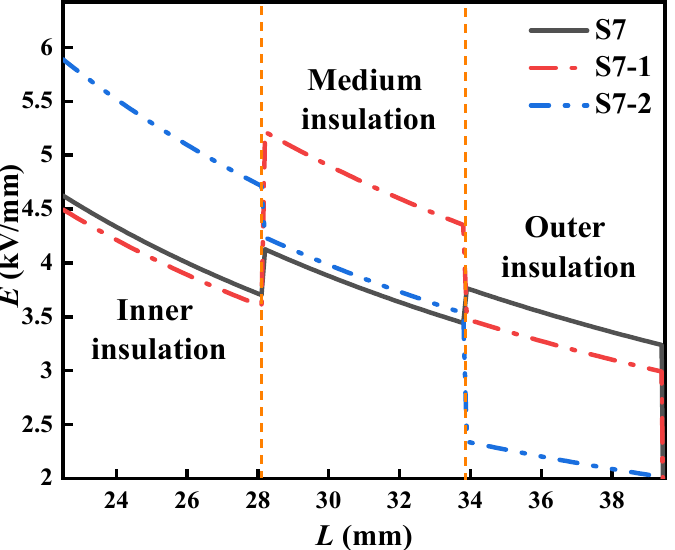
Figure 11. The electric field distribution in the cable insulation.